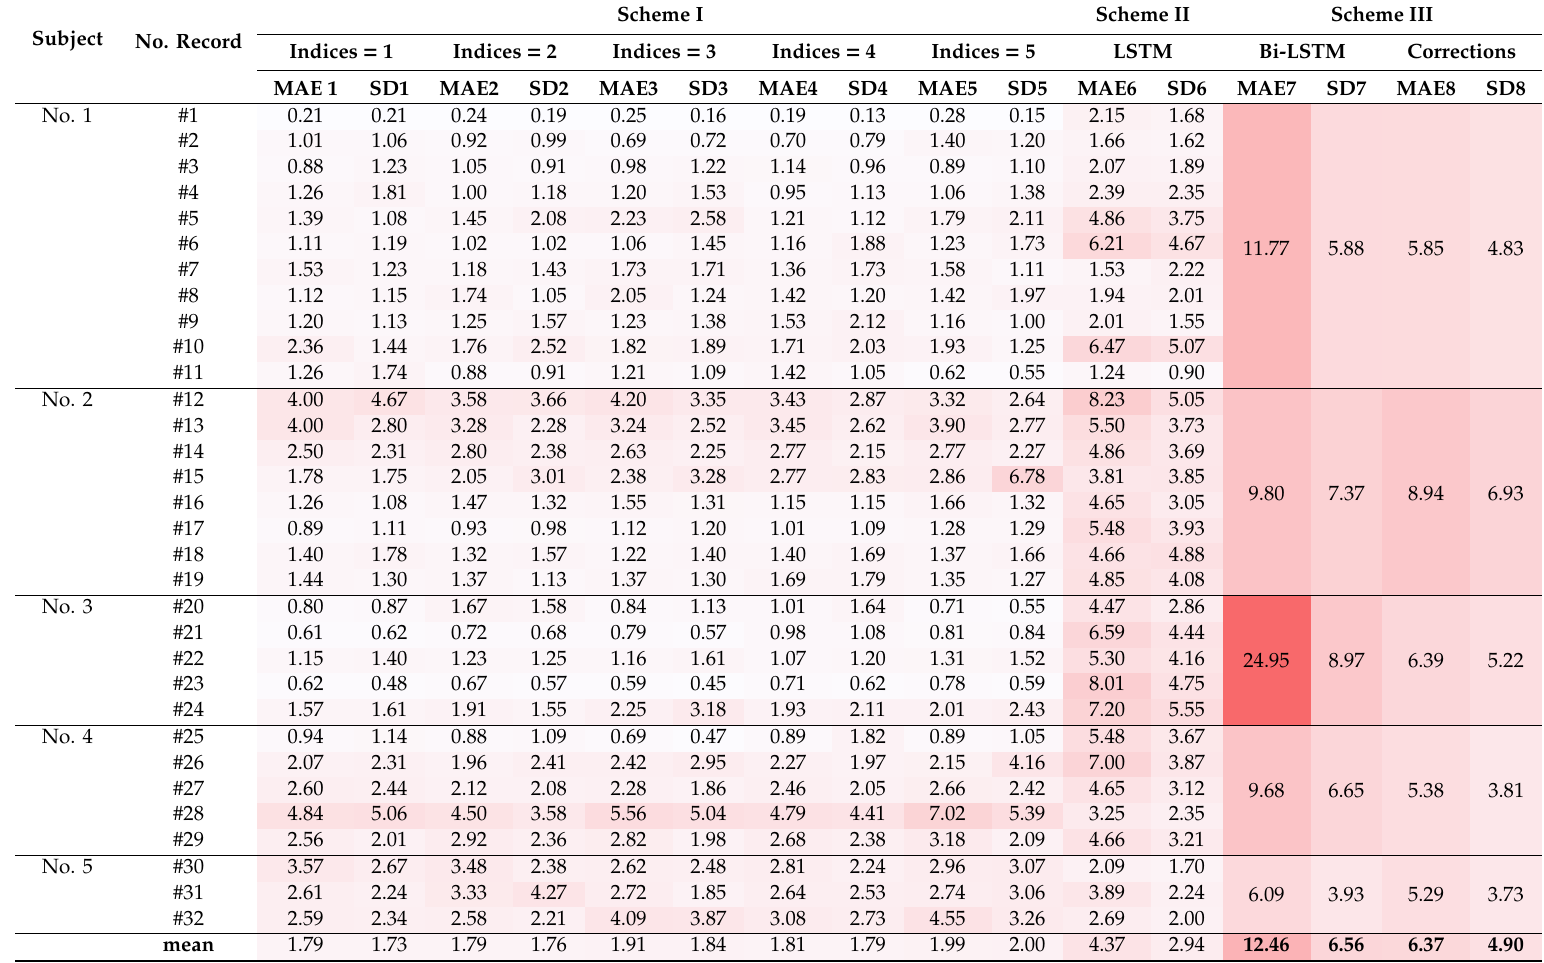
Table 2. The estimation performances of Bi-LSTM model for three